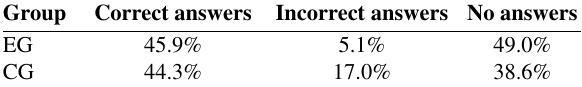
Table 8. Oxidation of the propan-2-ol; percentages of correct and incorrect